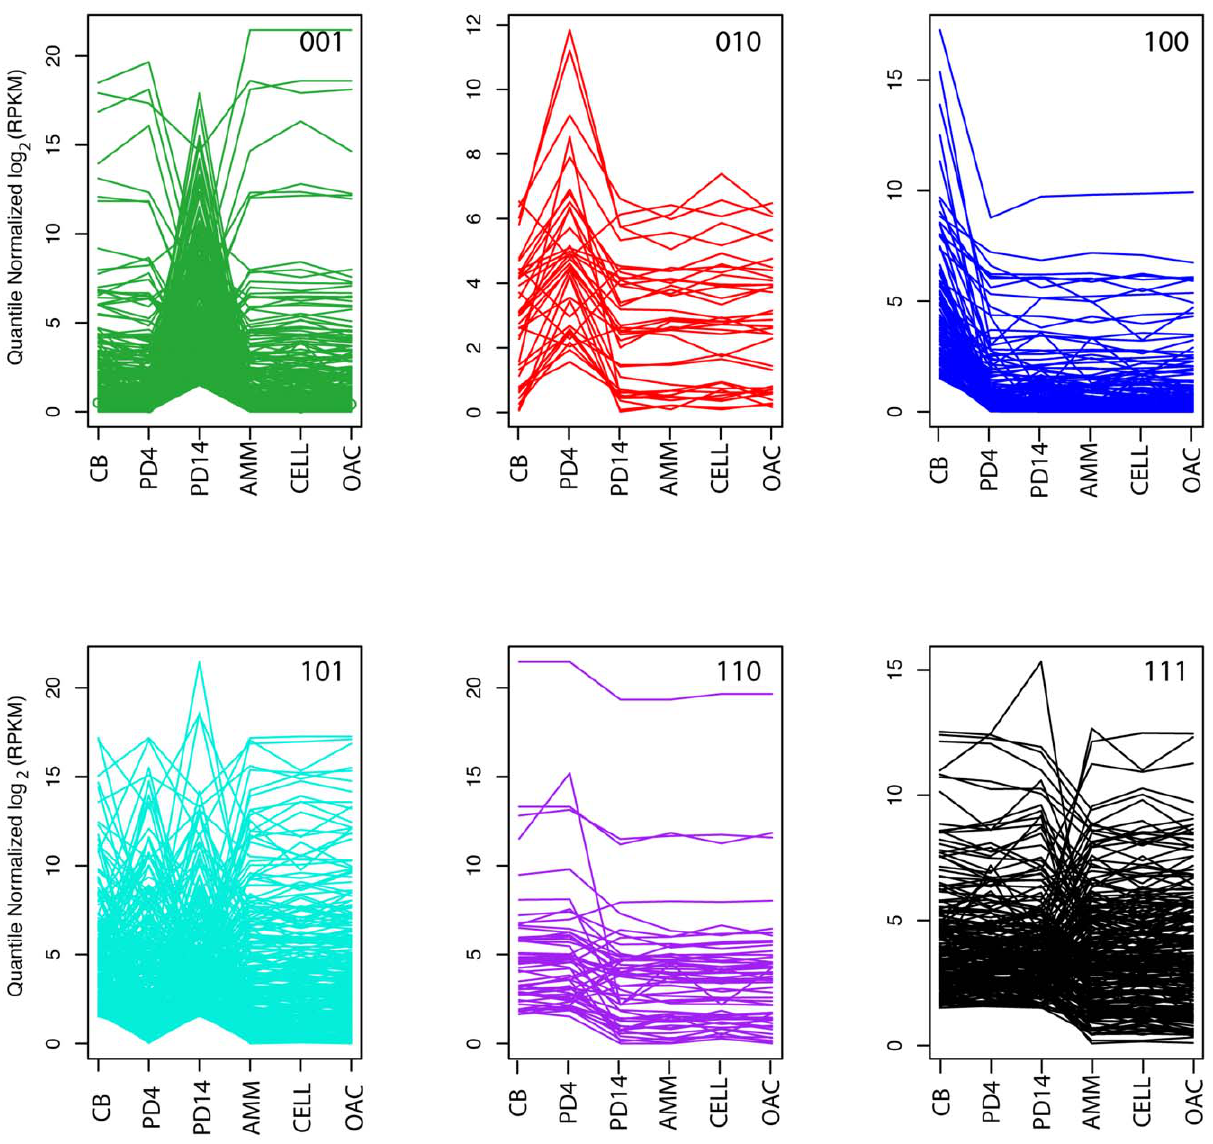
Figure 4. Compound gene co-expression profiles. Each plot shows the quantile-normalized log 2 (RPKM) for each set of genes of co-expressed with a particular compound profile (green 001, red 010, blue 100, cyan 101, purple 110, and black 111) across all 6 conditions (CB, PD4, PD14, AMM, CELL, and OAC). The first three conditions (CB, PD4, and PD14) represent the conditions where the compounds analyzed in this study were detected. The remaining conditions serve as the nulls (see Text S1for details). Within the plots, each line corresponds to a single